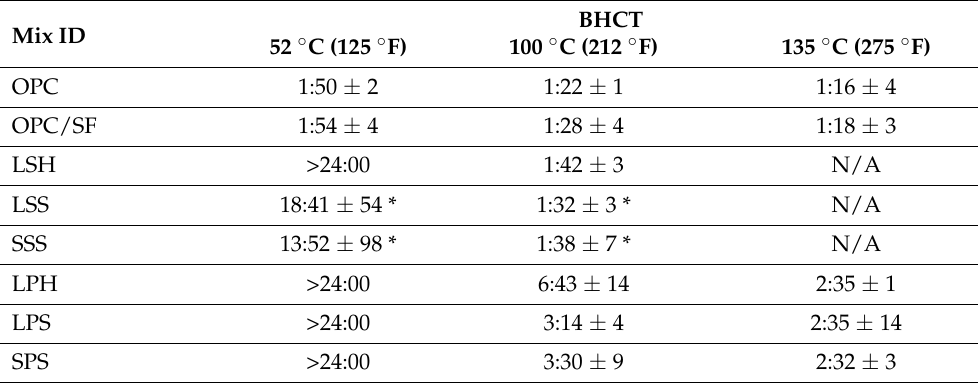
Table 5. Thickening time (formatted as hh:mm ± mm) for OPC and all geopolymer slurries. No retarders were used in any of the